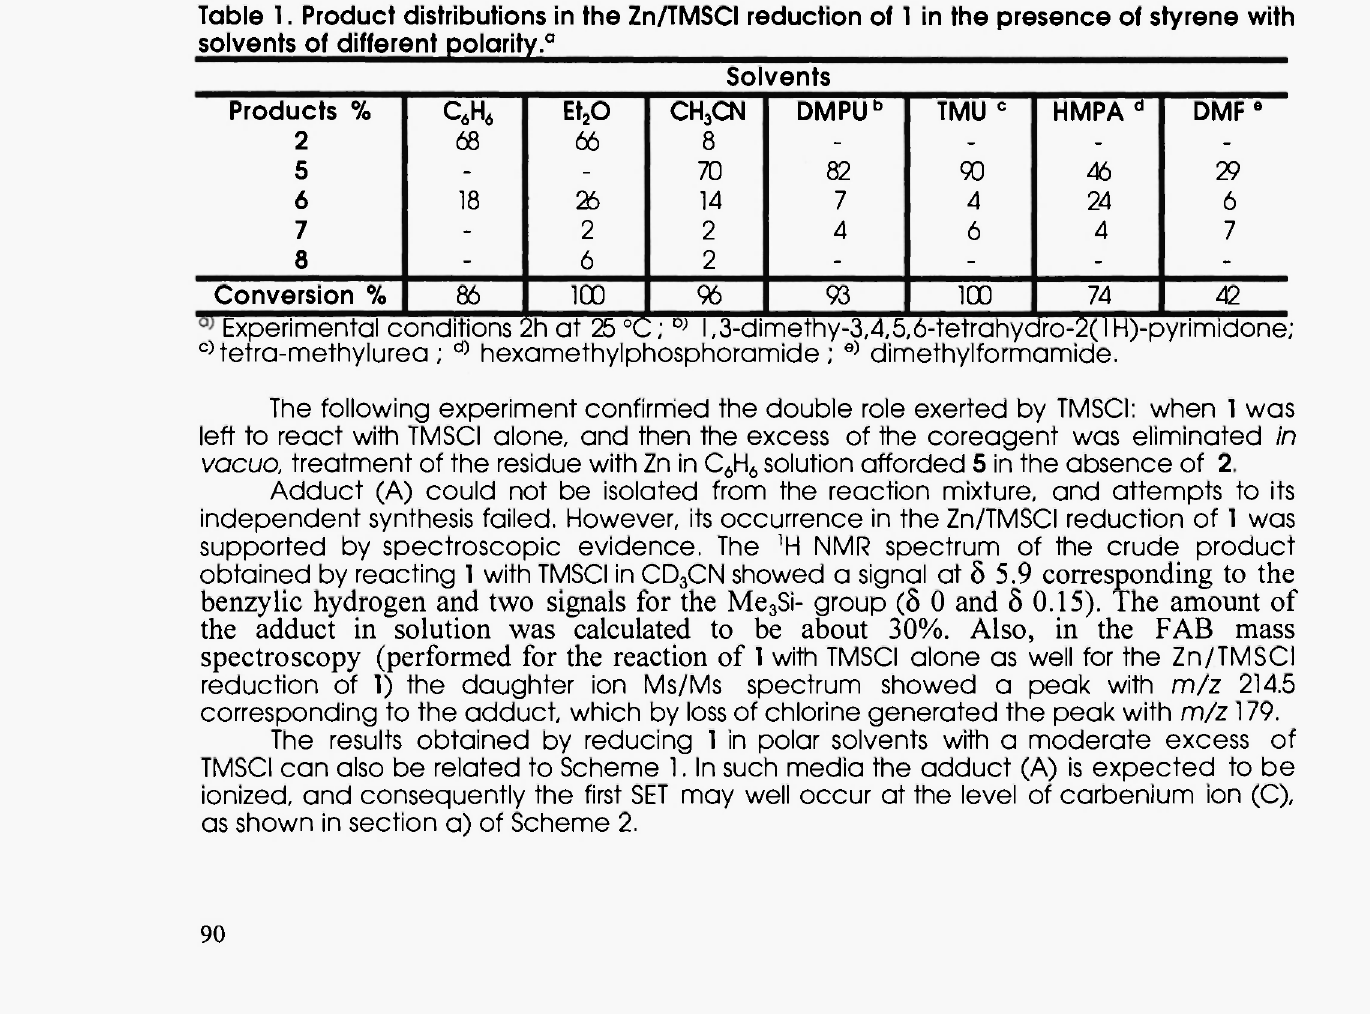
Table 1. Product distributions in the Zn/TMSCI reduction of 1 in the presence of styrene with solvents of different polarity.